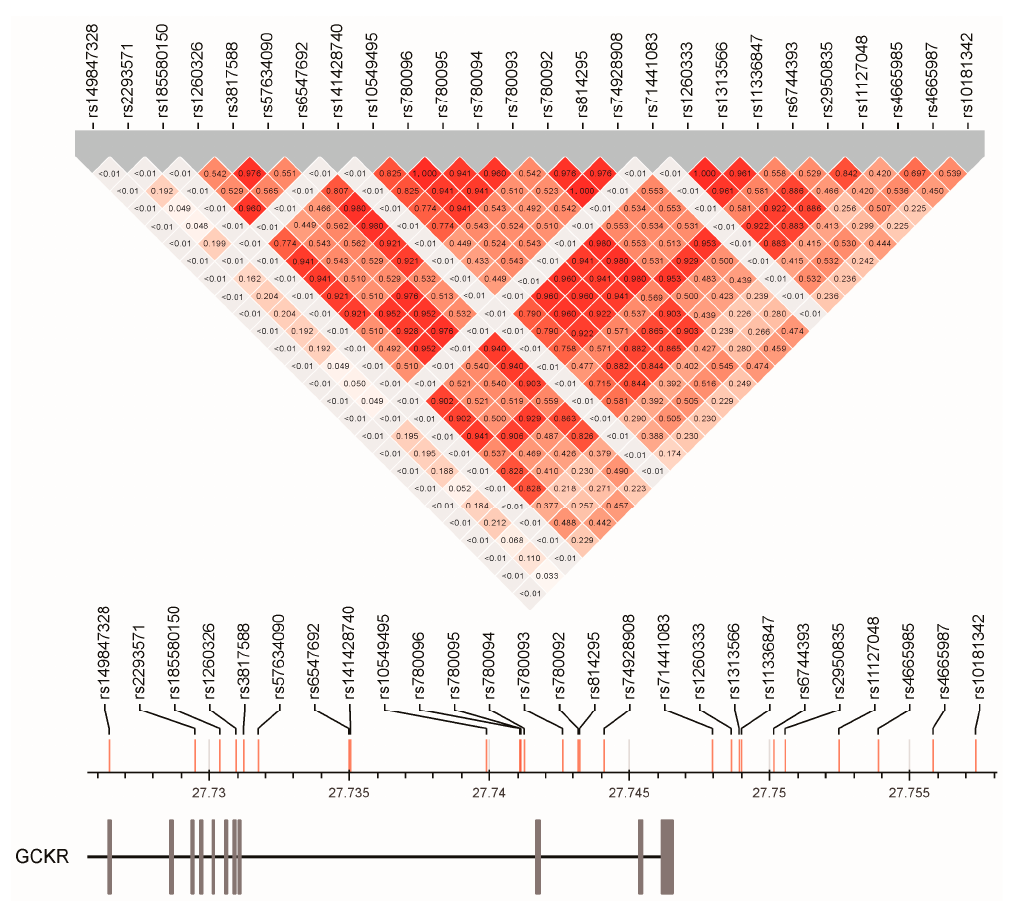
Figure 3. Linkage disequilibrium map of GCKR gene region single-nucleotide polymorphisms.